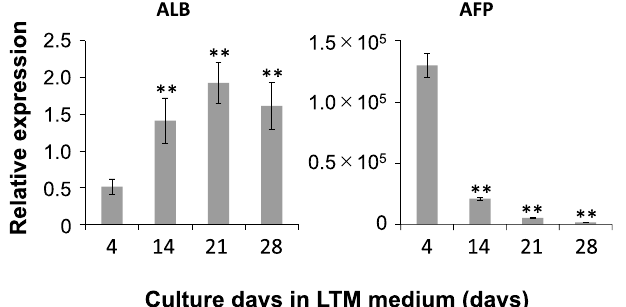
Figure 3. Expression of the genes which relate to the maturity of hepatocytes while cells were cultured in a long-term maintenance medium. The expression levels of ALB and AFP were measured using quantitative polymerase chain reaction over time during culture in a long-term maintenance medium for 28 days. The bar shows the relative expression levels of ALB or AFP. Pooled human liver RNA was used for the standard curve, and the expression level was set as one. The relative expression level was calculated using the equation of the line for the standard curve. Data are presented as means ± S.D. (n = 3). ** Shows that expression significantly increased compared with that on day 4 (P <